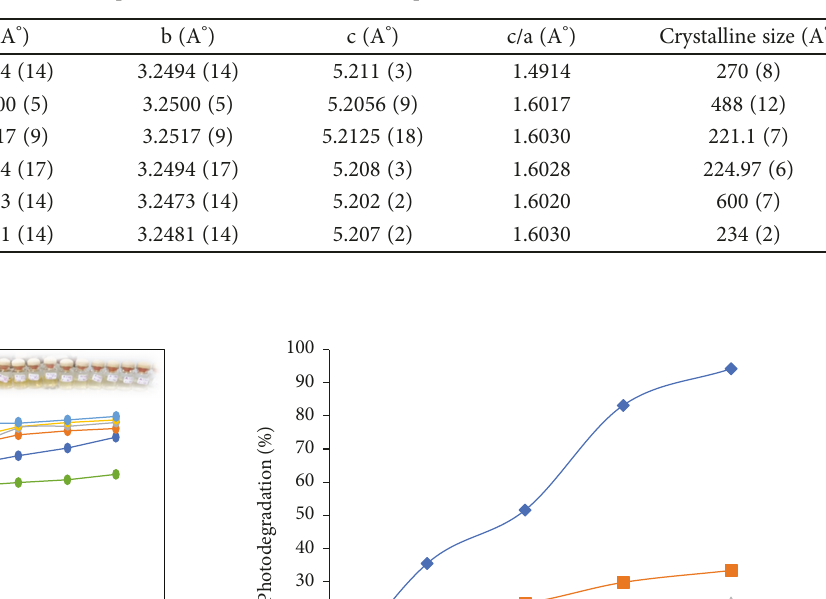
Table 1: The variation of lattice parameters with a variation of experimental conditions.